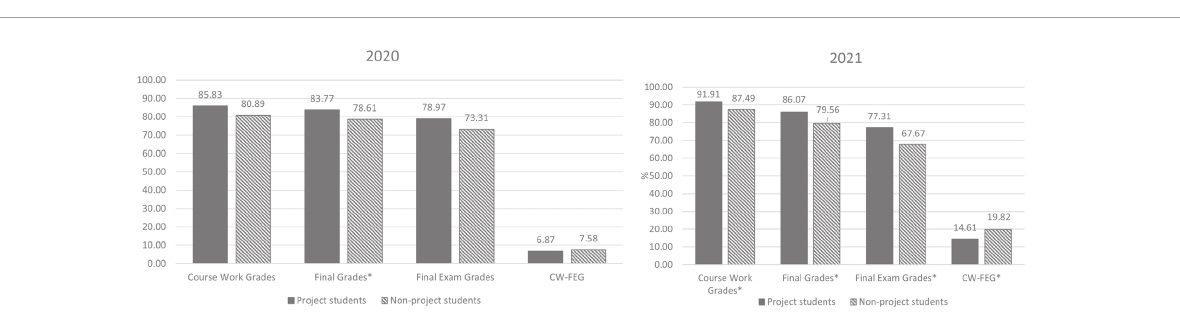
FIGURE2 Attainment of project and non-project students in 2020 and 2021. CW–FEG is the difference between the mean final exam grades and the mean course work grades. * denotes significant value at p ≤ 0.05. For other p -values please see Table 2 .